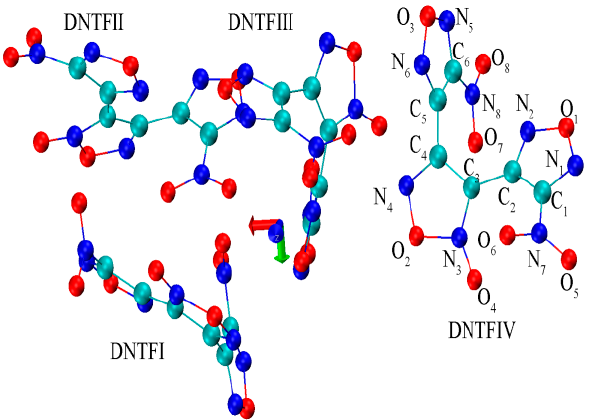
Figure 6. The optimized structure of the DNTF primitive cell includes four molecules, which are numbered using Roman numbers. The carbon (C), oxygen (O), and nitrogen (N) atoms are represented by blue-green, red, and blue-colored balls, respectively. Atoms in DNTF Ⅳ are labeled with elements and numbers, and the same rule is followed in other DNTF molecules.